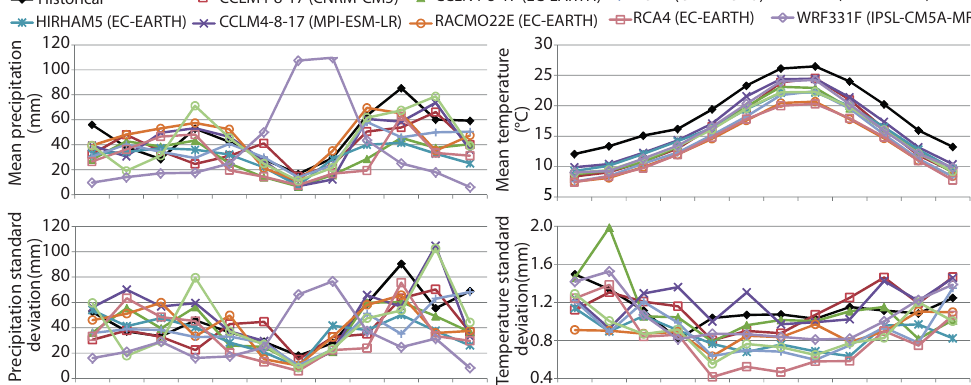
Figure 6. Monthly mean and standard deviation of the historical and RCMs control series (rainfall and temperature) for the mean year in the period 1976–2000. RCMs data obtained from CORDEX project.